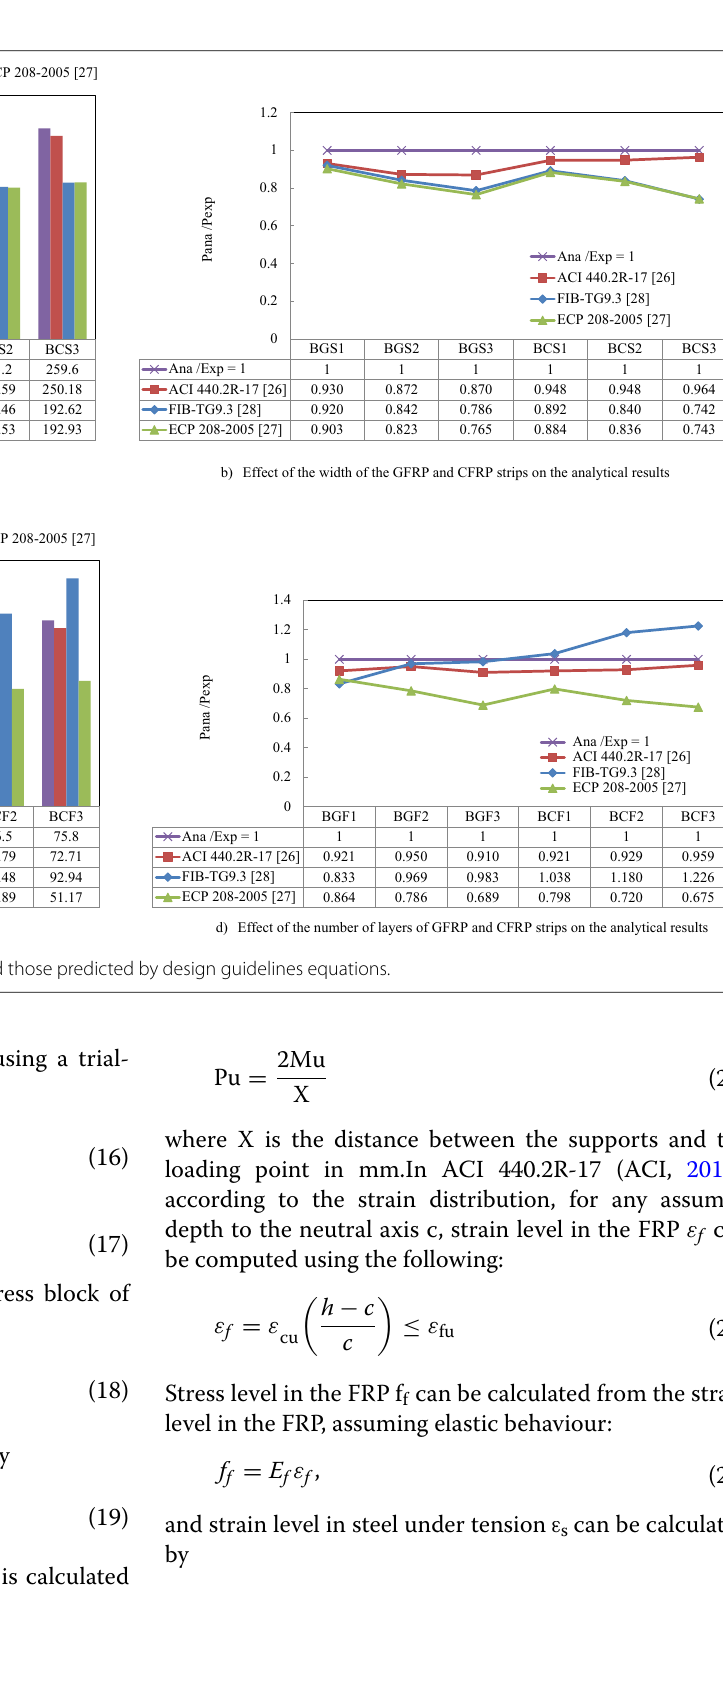
Stress level in the FRP f f can be calculated from the strain level in the FRP, assuming elastic behaviour: